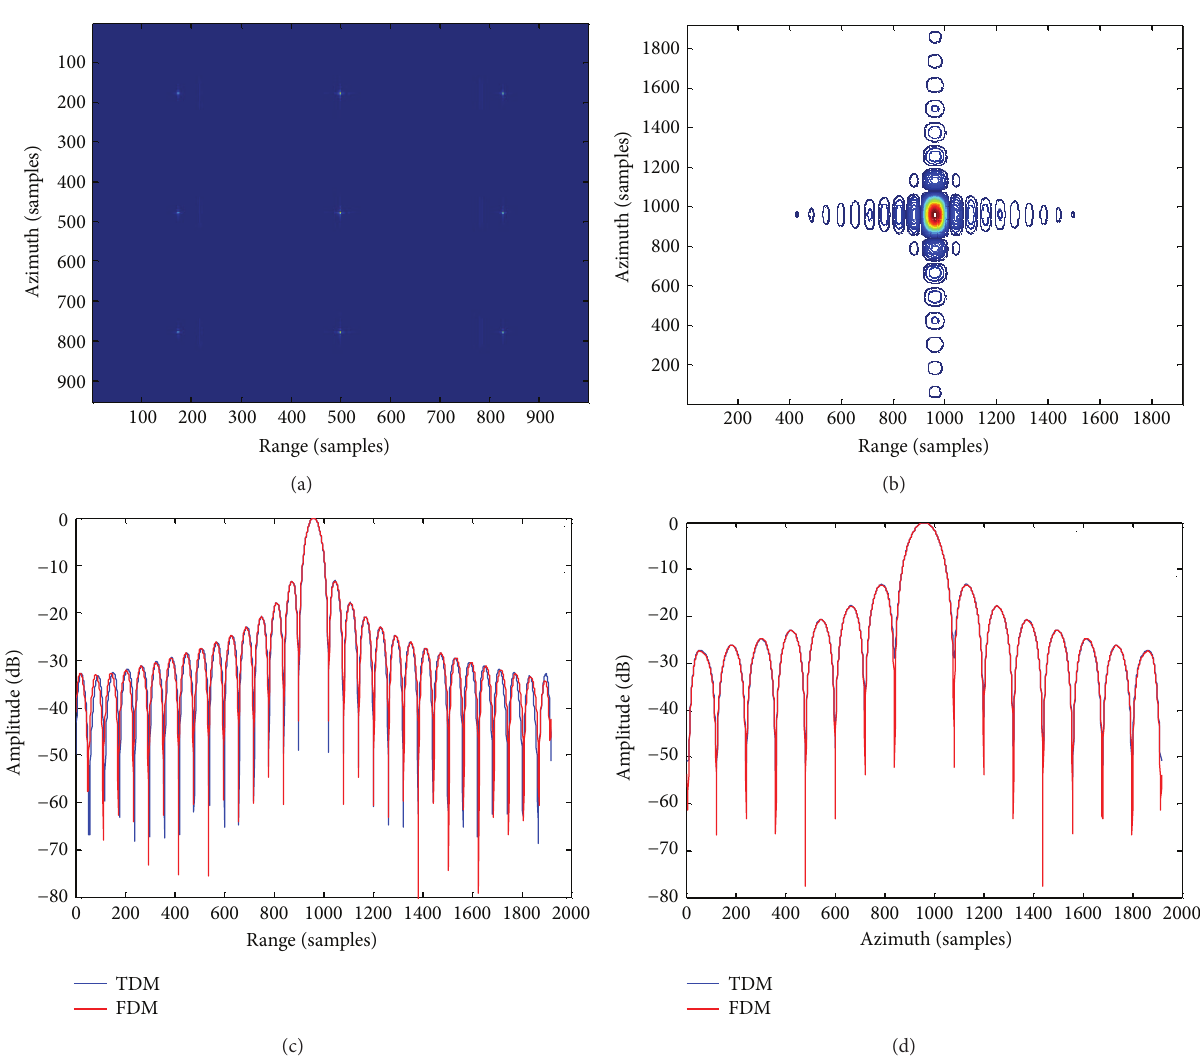
Figure 5: (a) The focused result of the generated raw data by the proposed simulator. (b) Interpolated contours of PT9. (c) Comparison with the range profiles of the resulting impulse response of PT9 of time domain method. (d) Comparison with the Azimuth profiles of the resulting impulse response of PT9 of time domain